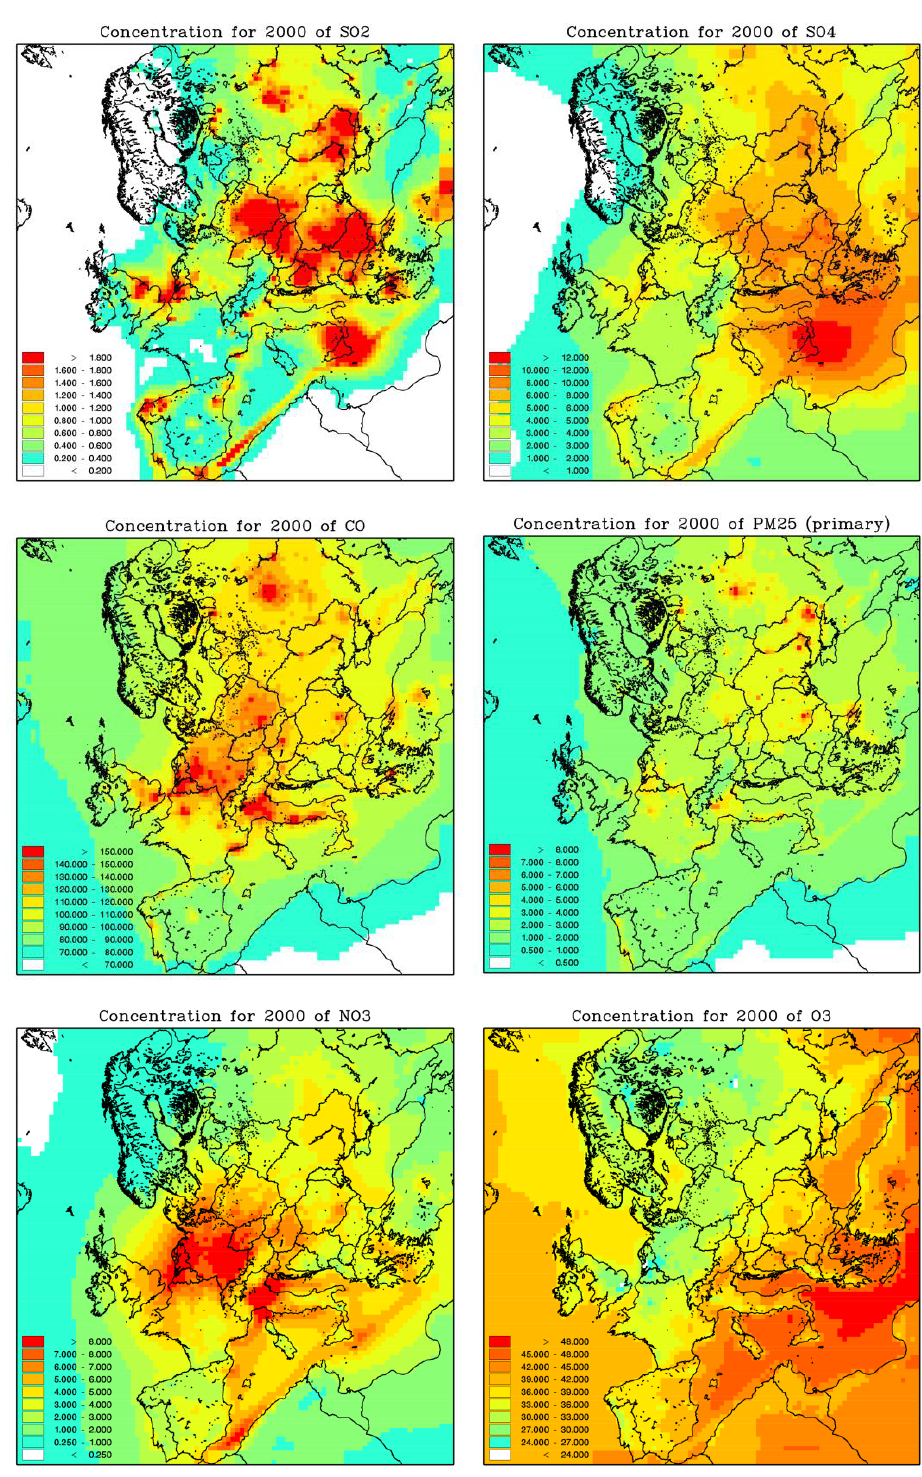
Fig. 2. As Fig. 1, but for DEHM European model